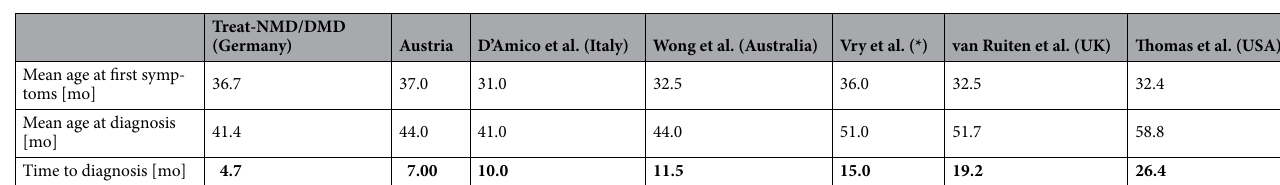
Table 1. Comparison of the diagnostic delay in different countries. Significant values are given in bold. *Bulgaria, Czech Republic, Denmark, Hungary, Poland, Germany and UK.